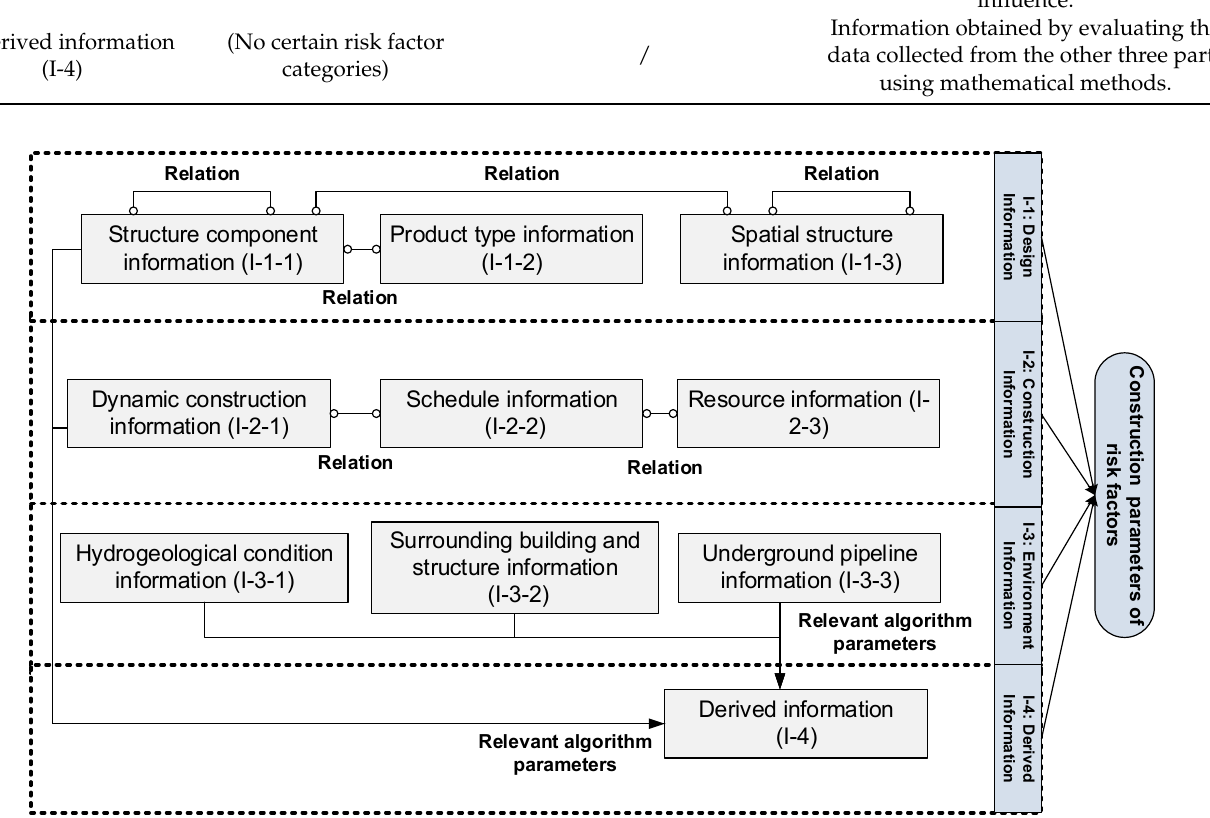
Figure 3. IFC expression framework of risk information for safety risk identification.